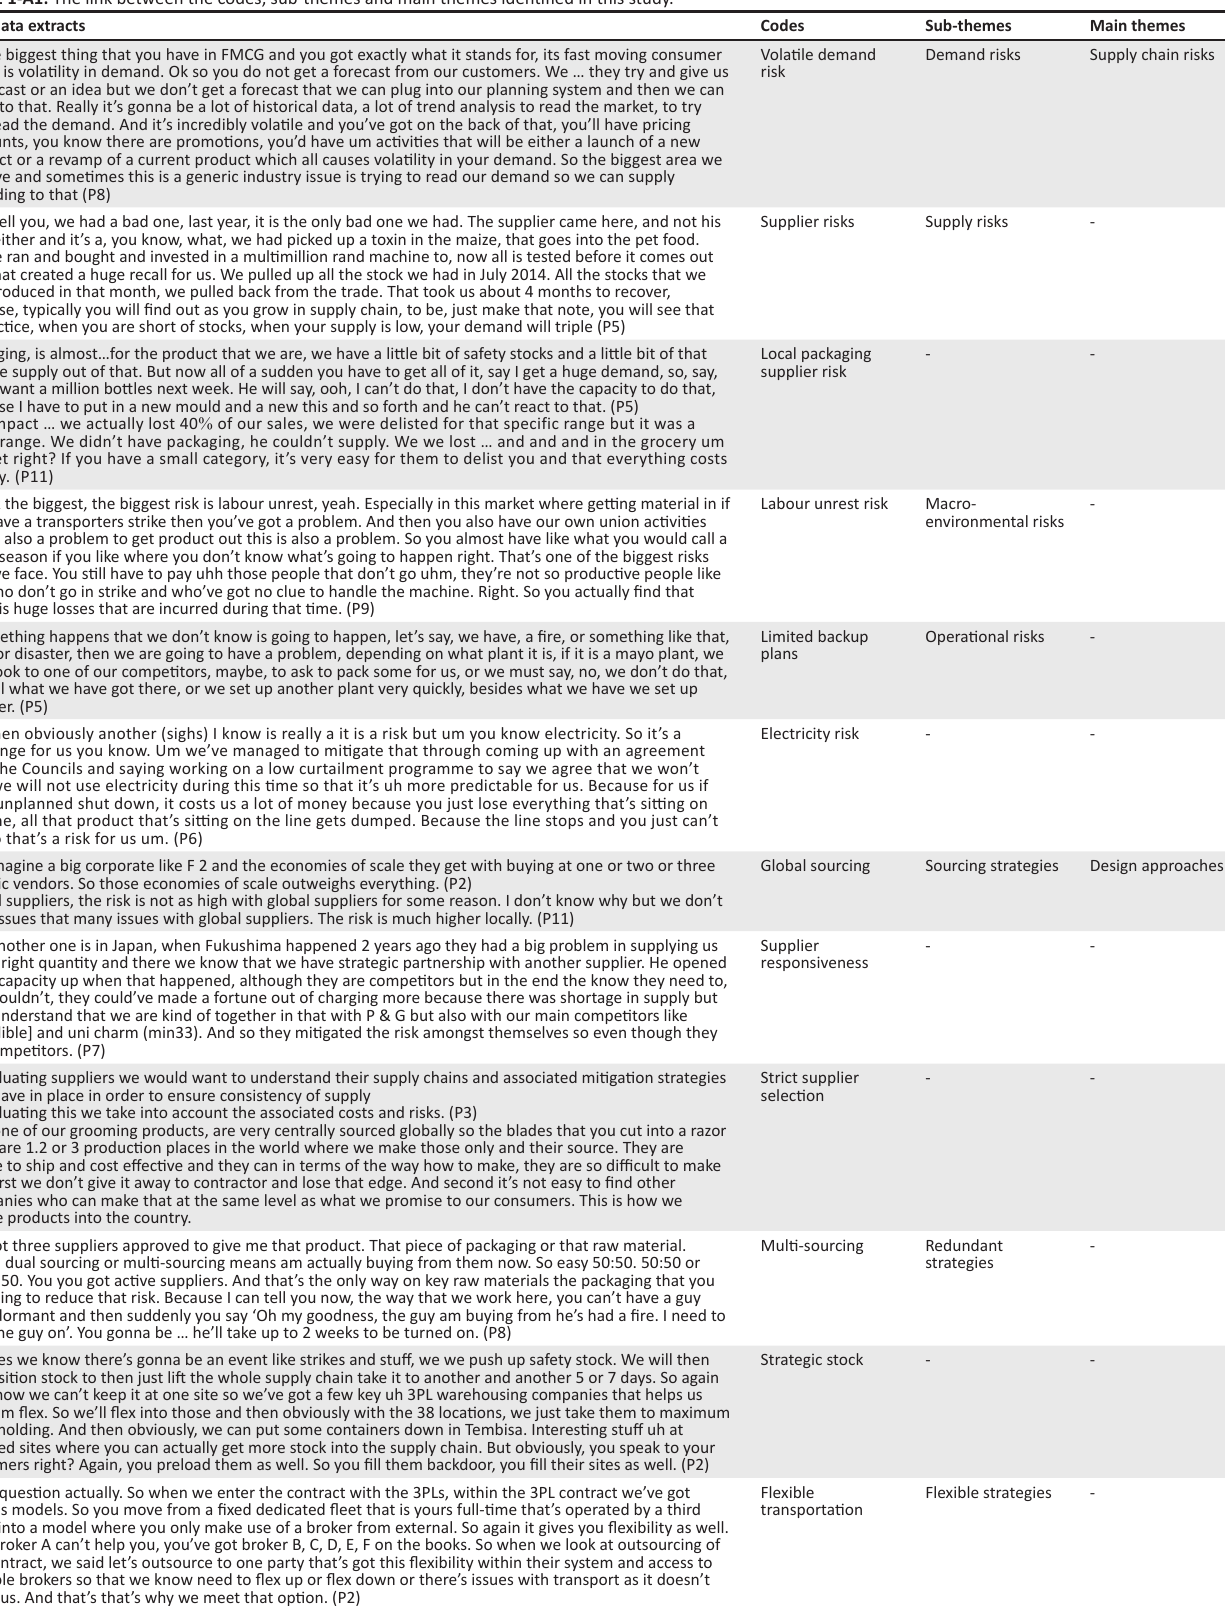
TABLE 1-A1: The link between the codes, sub-themes and main themes identified in this